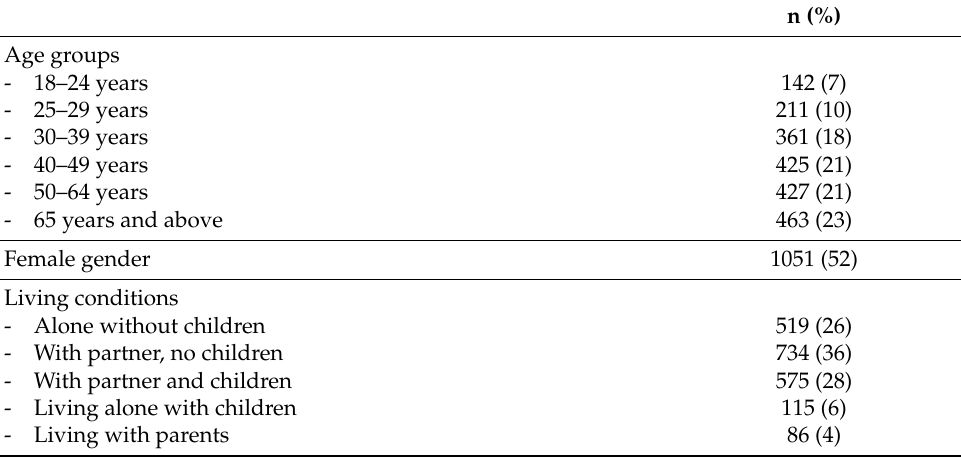
Table 1. Sample description. All individuals (n =